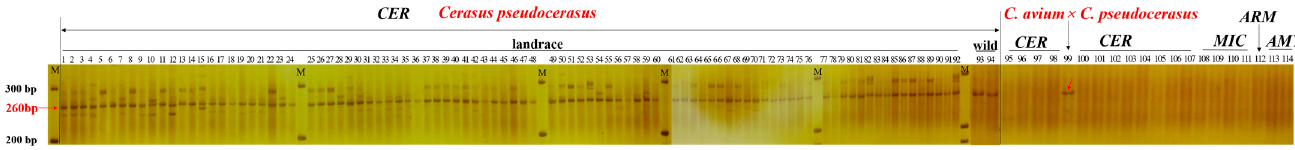
Figure 3. PCR profile of the SSR marker SAUCps203 with species-specificity in Cerasus pseudocerasus .